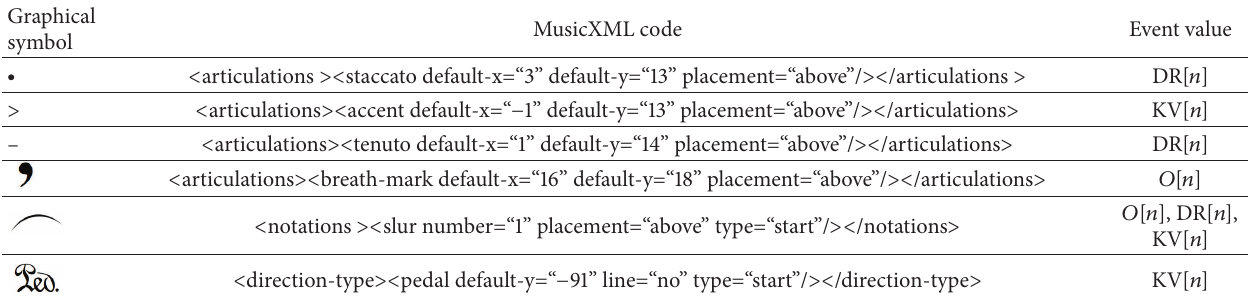
Table 2: Correspondence among graphical expressive cues, XML representation, and rendering